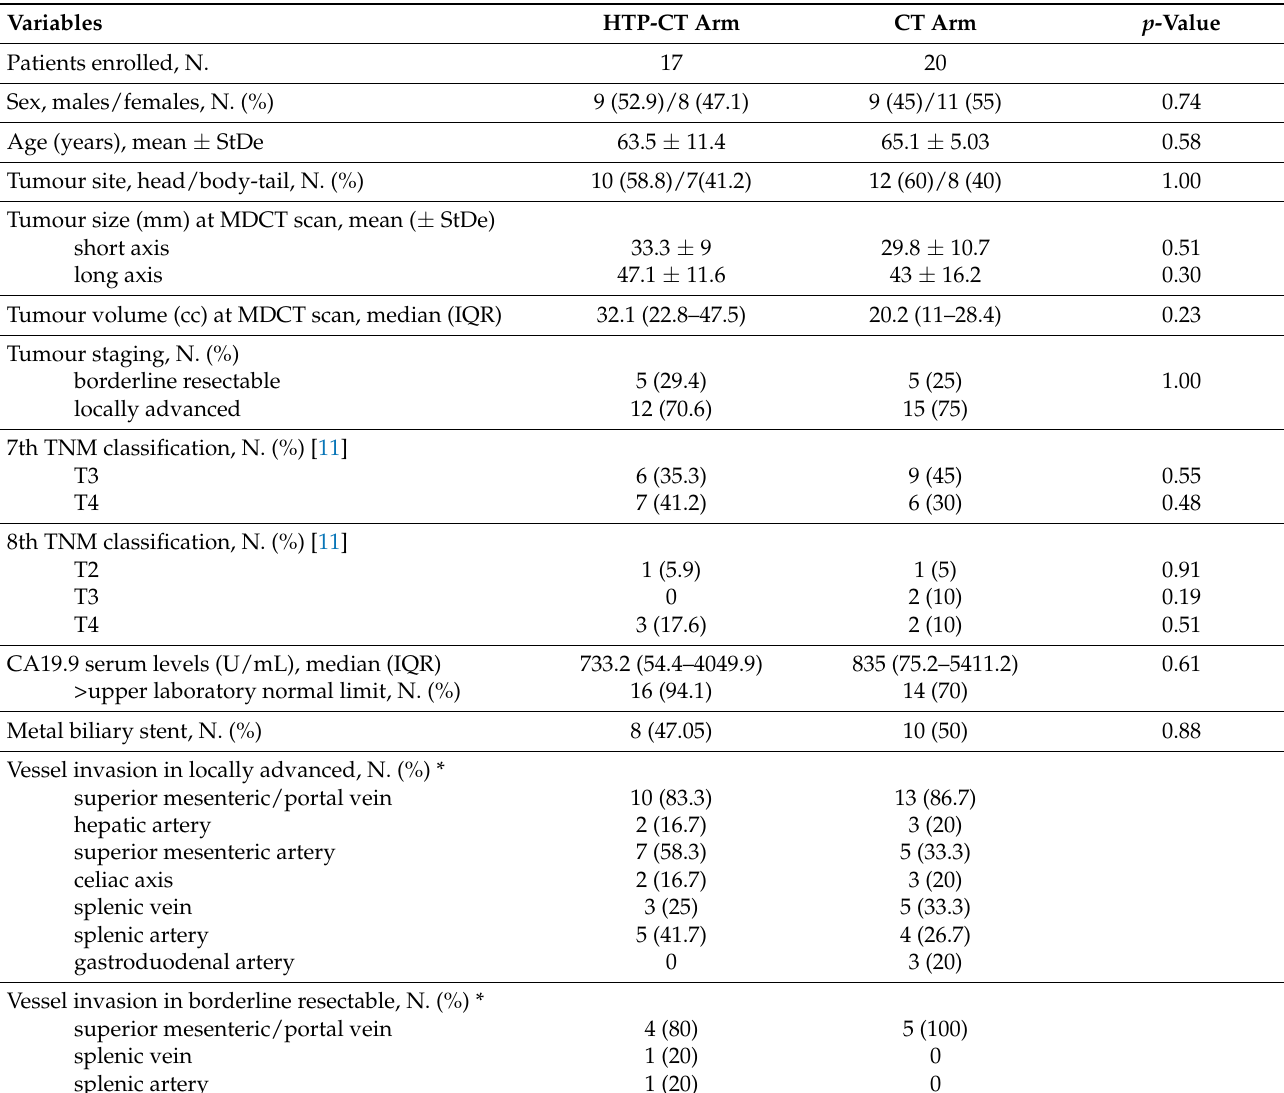
Table 1. Baseline clinical and tumour features of the enrolled patients according with randomization in the two treatment arms. Variables HTP-CT Arm CT Arm p -Value Patients enrolled,